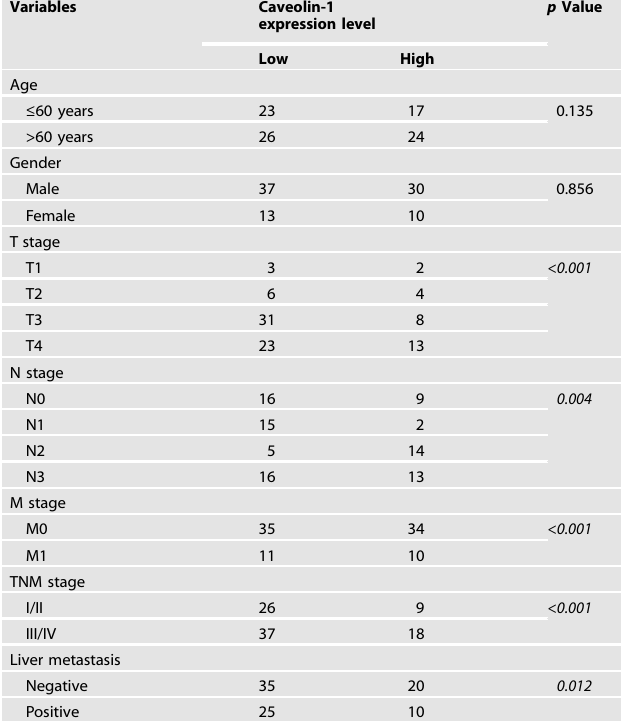
Table 2. Association between caveolin-1 expression and clinicopathological characteristics in gastric cancer.